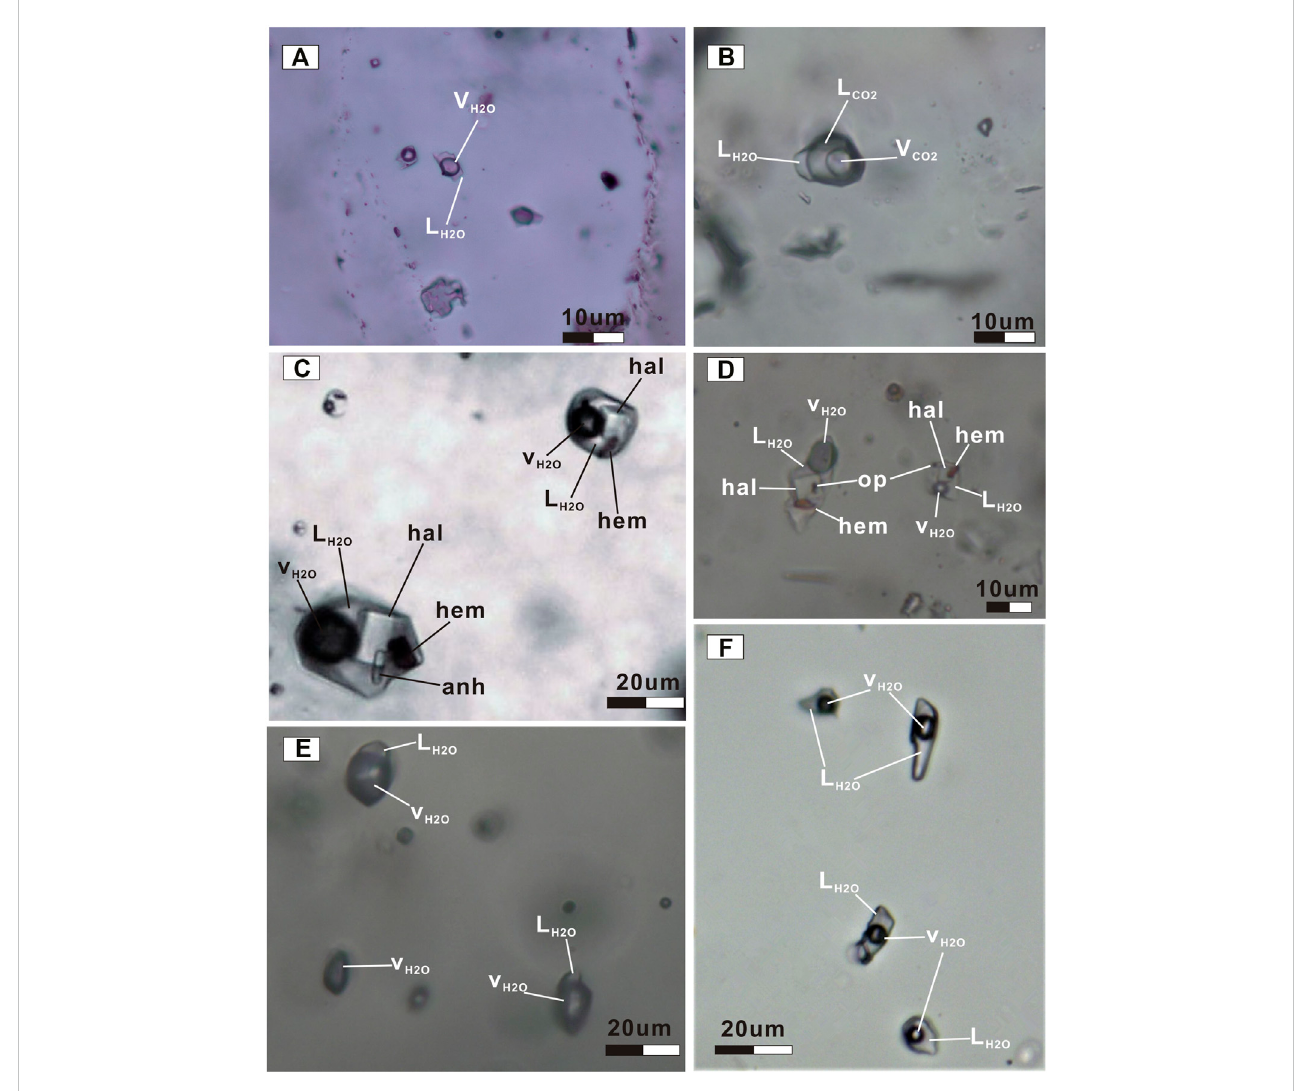
FIGURE 6 Representative fl uid inclusion types in Wunugetushan porphyry Cu-Mo deposit. (A) C-type inclusions in early Mo mineralization stage and (B) late Mo mineralization stage. (C) S-type inclusions in late Mo mineralization stage and (D) Cu mineralization stage. (E) V-type inclusions in early Mo mineralization stage and (F) L-type inclusions in Cu mineralization. Abbreviations: L H2O - liquid H 2 O, L CO2 - liquid CO 2 , V CO2 - vapor CO 2 , V H2O - vapor H 2 O, hal-halite, hem- hematite, anh-anhydrite, op-opaque